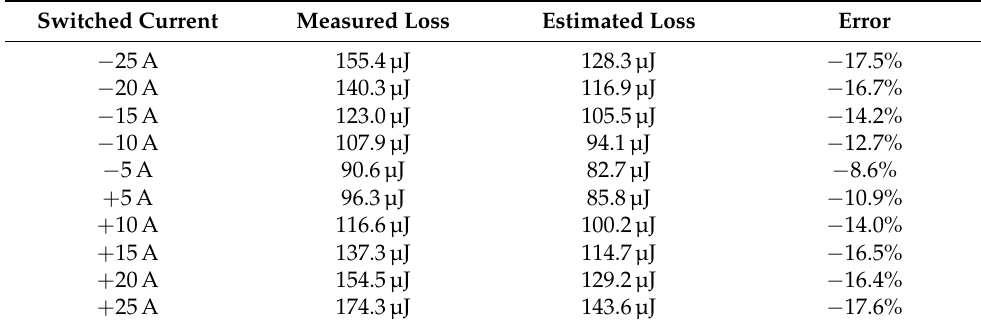
Table 1. Comparison between estimated and measured hard-switching losses in the 3LTT bridge-leg as a function of the switched current I sw at V dc = 800V and T j ≈ 125°C. The losses are estimated with (15) for I sw > 0 and with (16) for I sw <